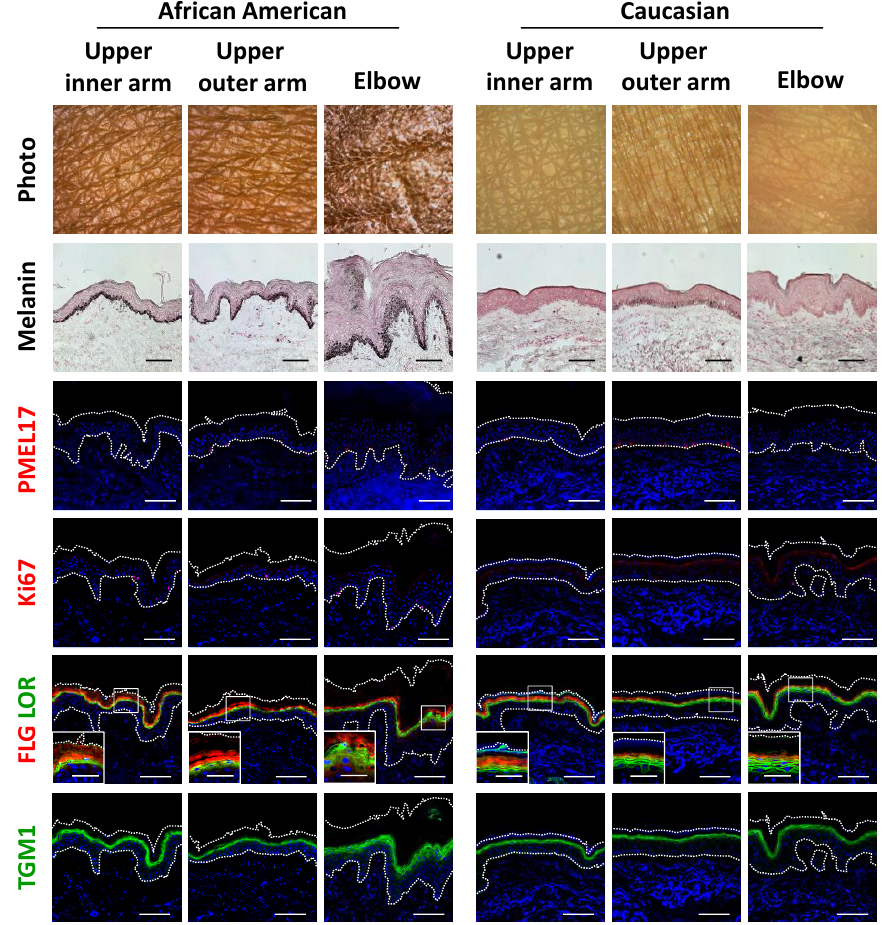
Figure 4. Disruption of epidermal differentiation leads to extensive melanin accumulation and abnormal epidermal development in dark joint regions. Biopsied skin samples were obtained from upper inner arm, upper outer arm and elbow areas of AA and Caucasian subjects, then subjected to Fontana-Masson staining and immunofluorescence observations. Merged images of PMEL17 (red), Ki67 (red), a set of filaggrin (FLG) (red) and loricrin (LOR) (green) or transglutaminase 1 (TGM1) (green), and DAPI nuclear staining are shown. Lower insets show magnification of areas inside white rectangles. Bars = 100 μm or 50 μm (insets).